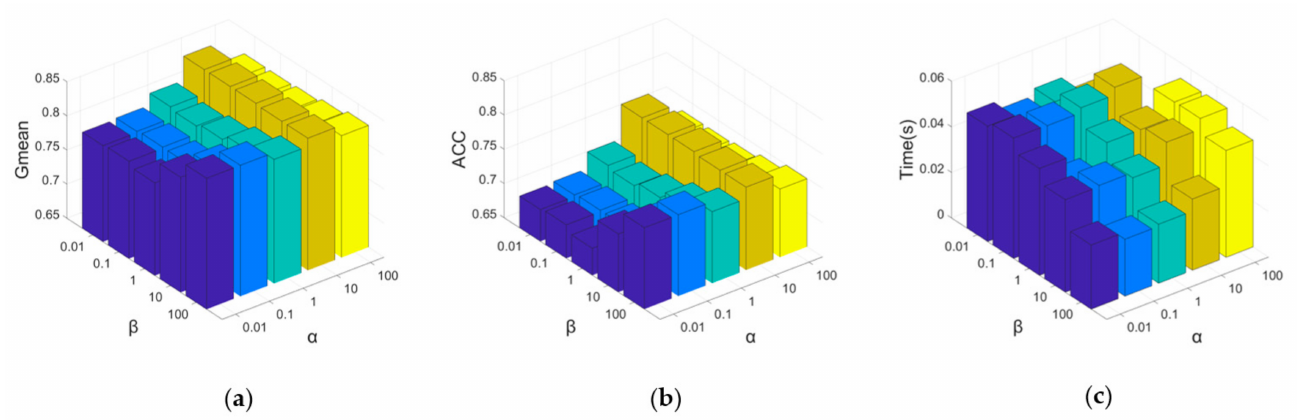
Figure 3. Performance variation of HMVFS with different values for the parameters α and β in terms of ( a ) Gmean; ( b ) ACC; ( c )